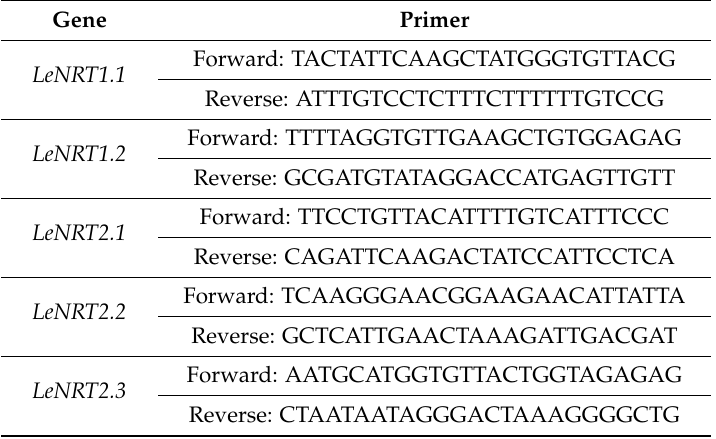
Table 3. Gene-specific primers for RT-PCR (Yao et al.,